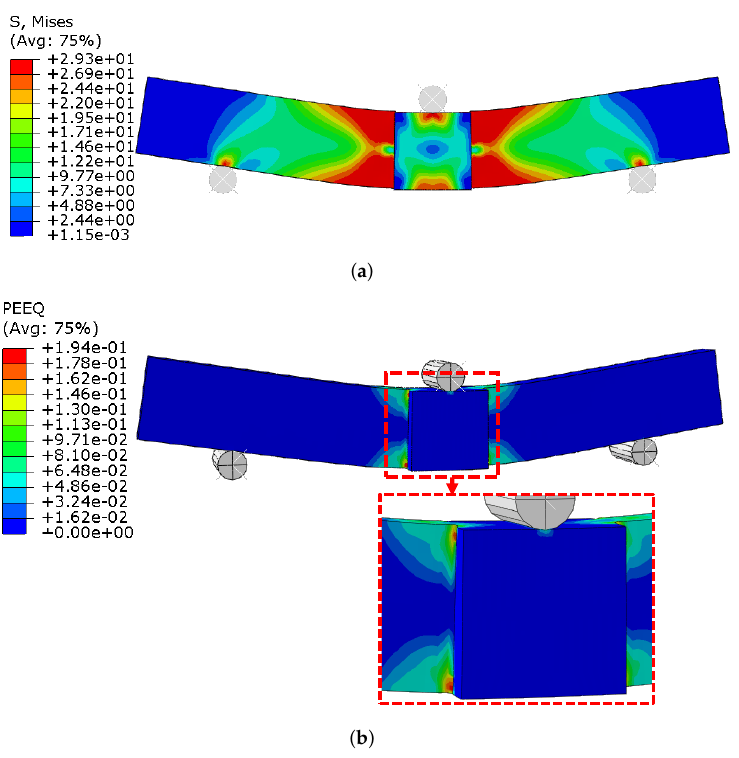
Figure 16. ( a ) Stress and ( b ) deformation plots for the